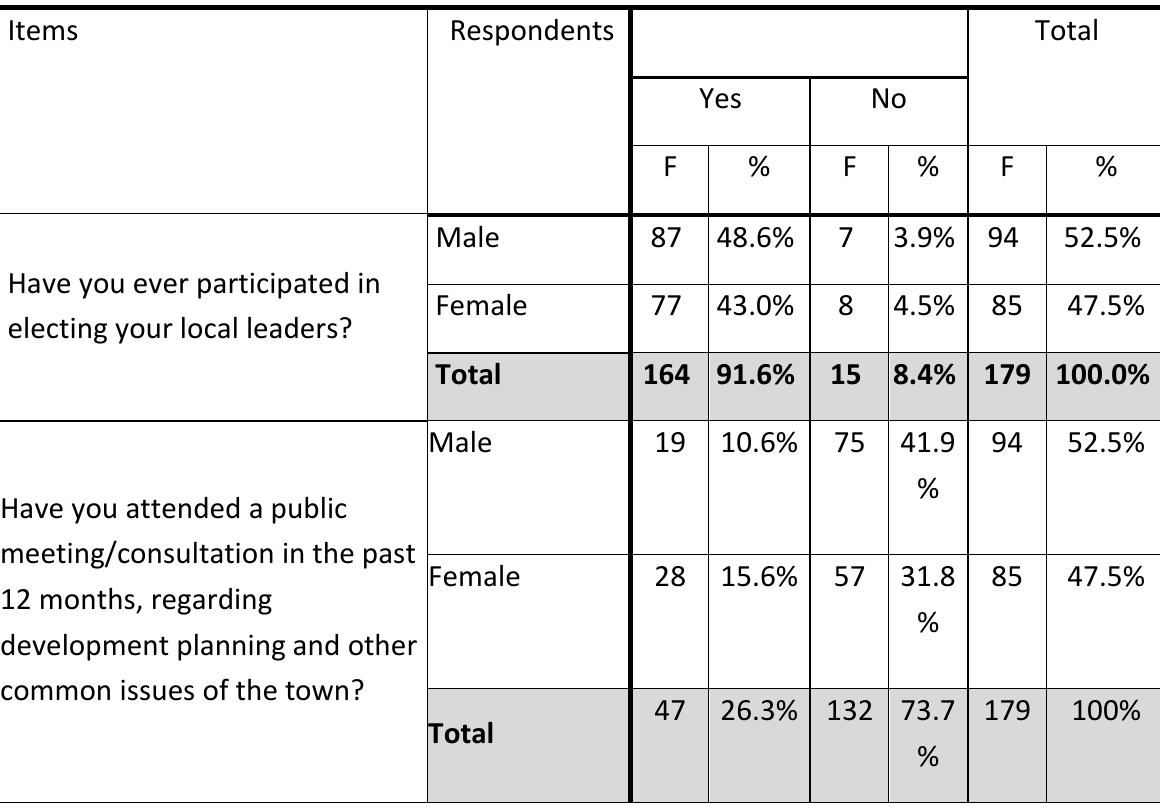
Table 10: Citizens participation in local election and meeting attendance on various issues of the town